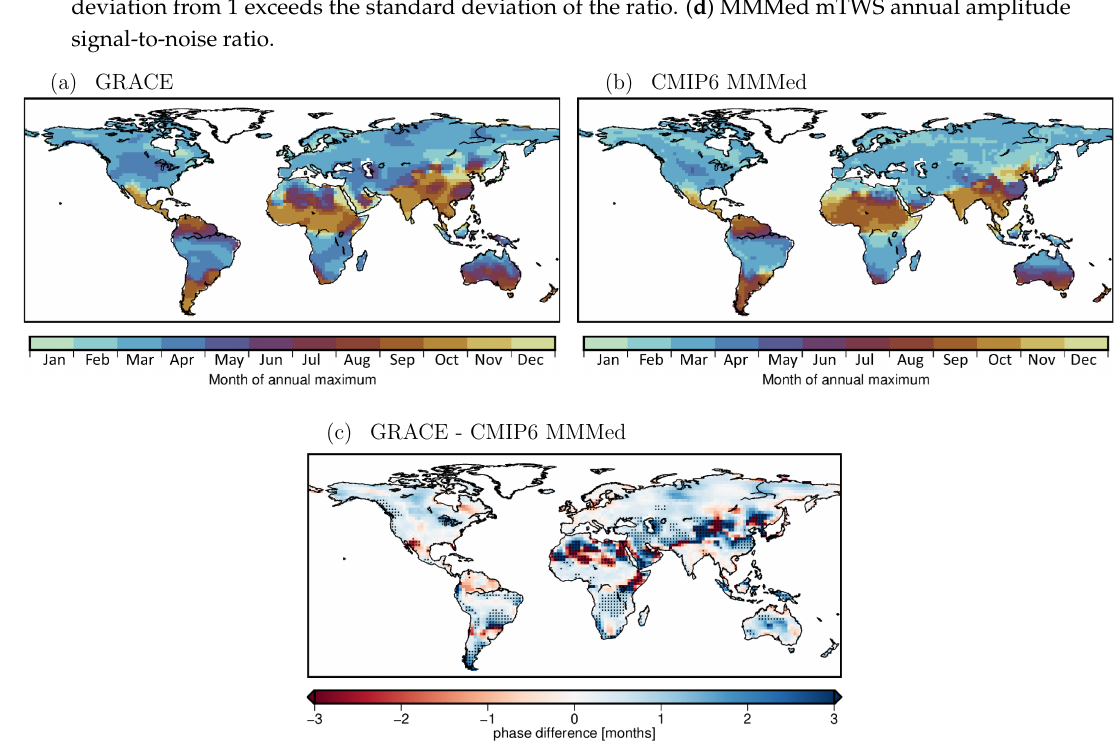
Figure 5. ( a ) GRACE TWS month of the maximum of the annual cycle and ( b ) MMMed mTWS month of the maximum of the annual cycle for the time span 2002/04–2020/04. ( c ) Difference of ( a , b ). Stippling indicates regions where the difference exceeds the standard deviation of the